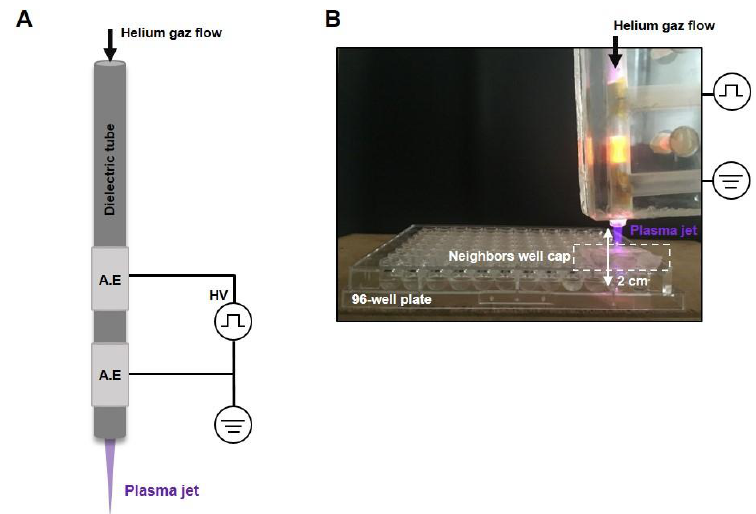
Figure 6. The cold-atmospheric plasma jet configuration. ( A ) Schematic representation of the